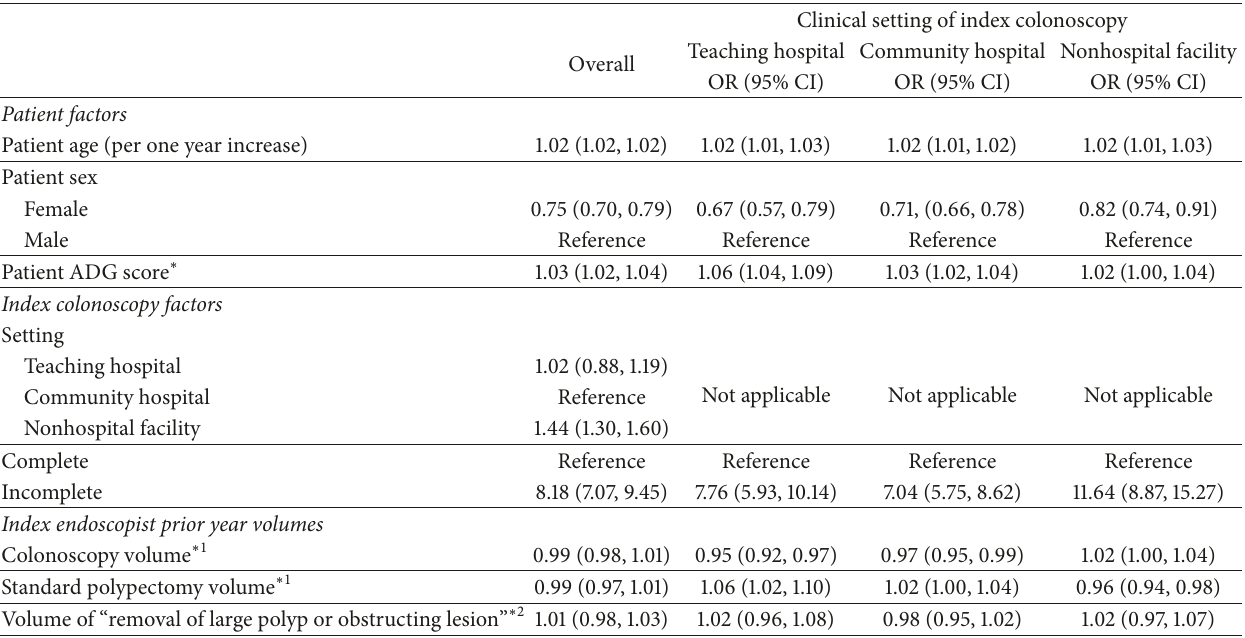
Table 4: Adjusted odds ratios for very early repeat colonoscopy among patients with polypectomy or biopsy at index procedure #